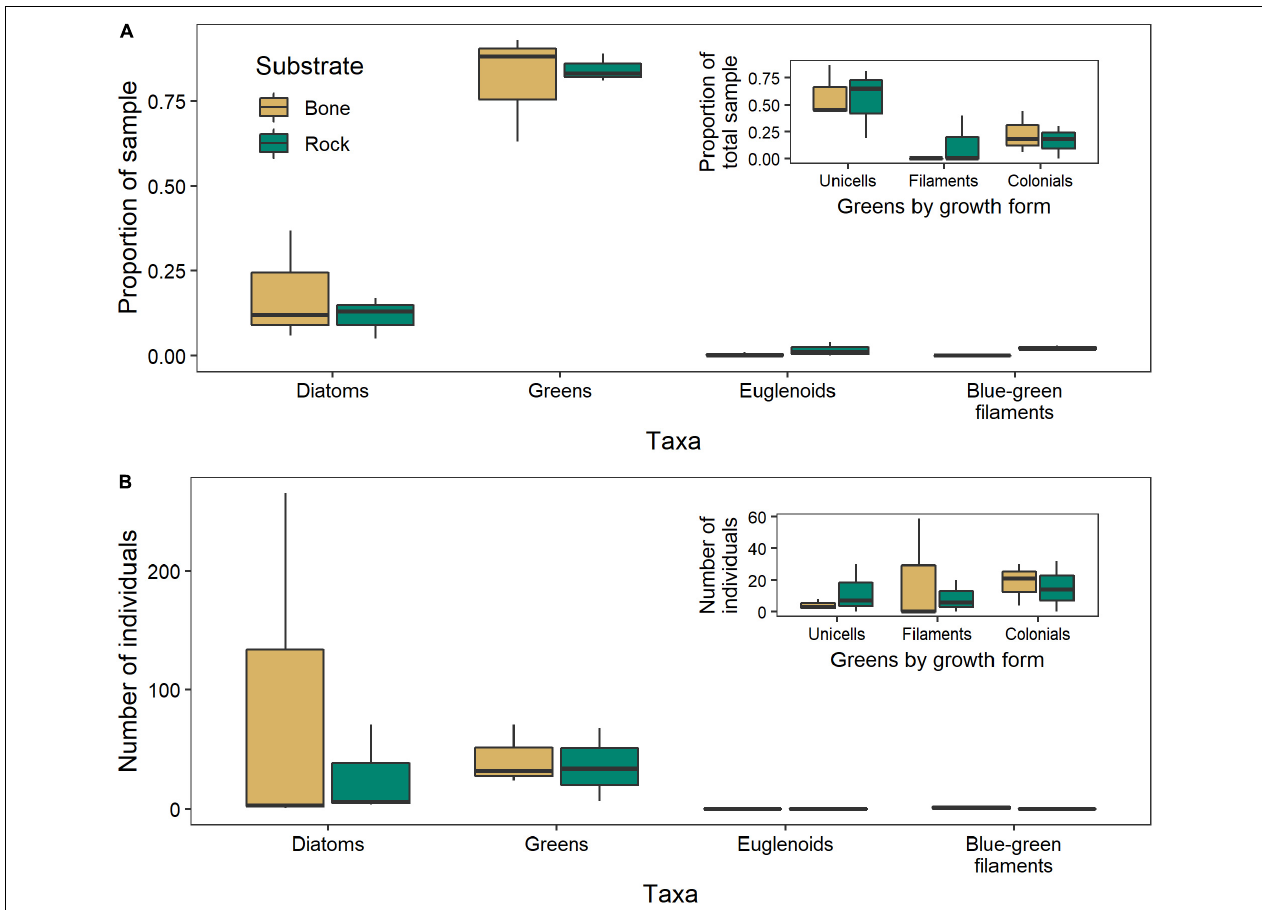
FIGURE 9 | Algal community composition on bone ( n = 3) and rock ( n = 3) substrates in the Mara River, where individuals are presented as (A) a proportion of 100 individuals counted in 2017, or (B) total number within 10 microscope fields in 2018. Green algae are parsed by growth form in the inset figures.